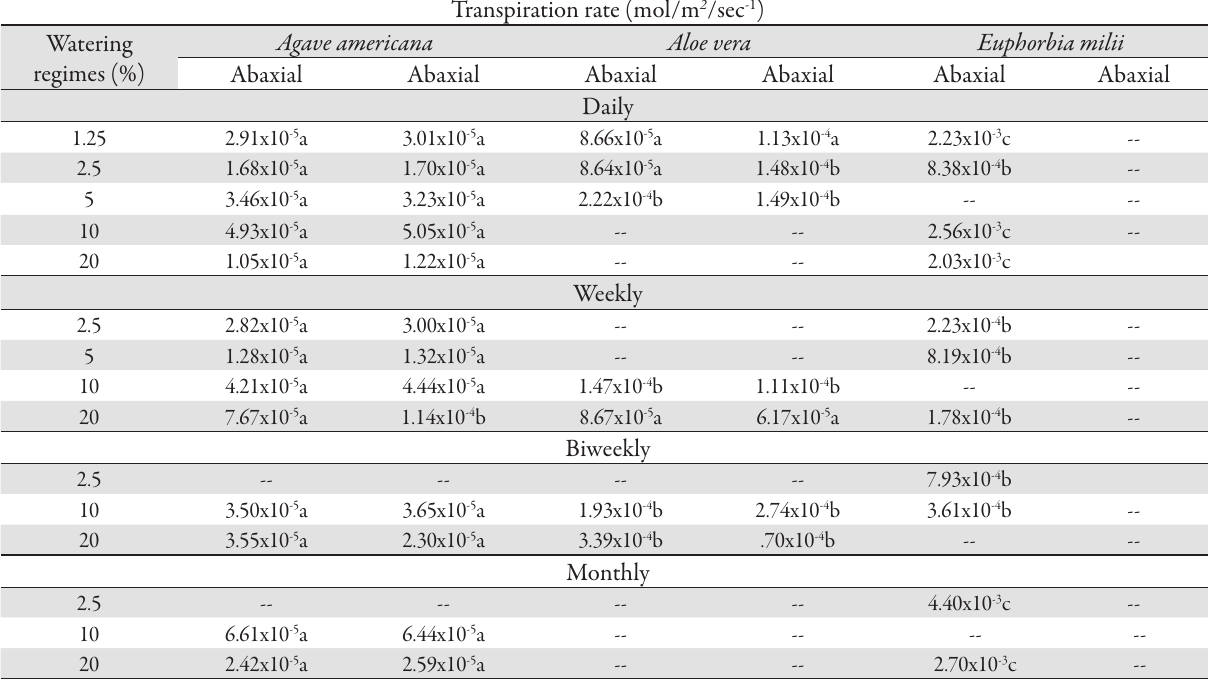
Tab. 7. Transpiration rate of some ornamental plant species propagated with different percentage moisture